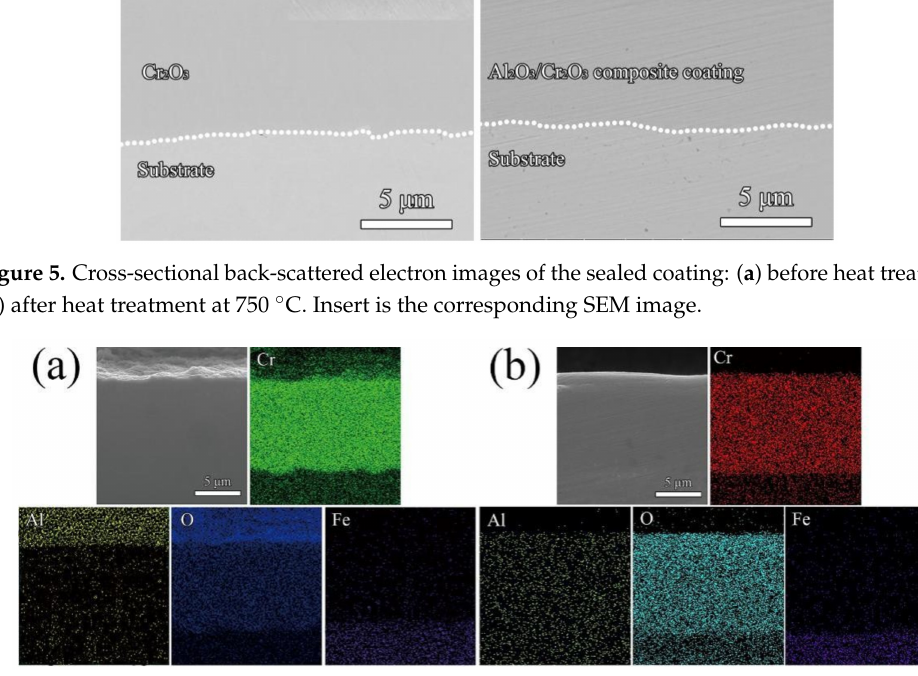
Figure 6. Cross-sectional SEM image and EDS elemental maps of the sealed coating: ( a ) before heat treatment; ( b ) after heat treatment at 750 ◦